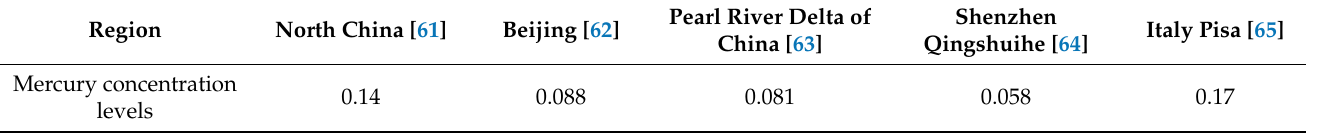
Table 10. Mercury content levels in domestic and international research cases (unit: mg/kg).